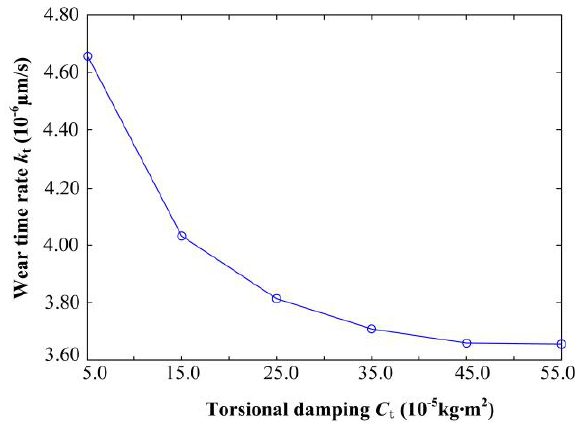
Figure 17. Wear time rate for different torsional damping values.